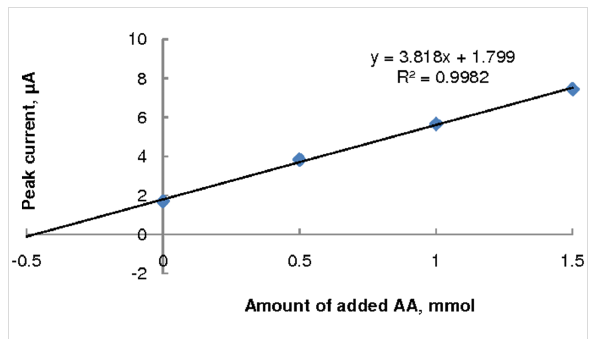
Figure 6: Standard addition plot of SWV data for (1/5)-diluted juice